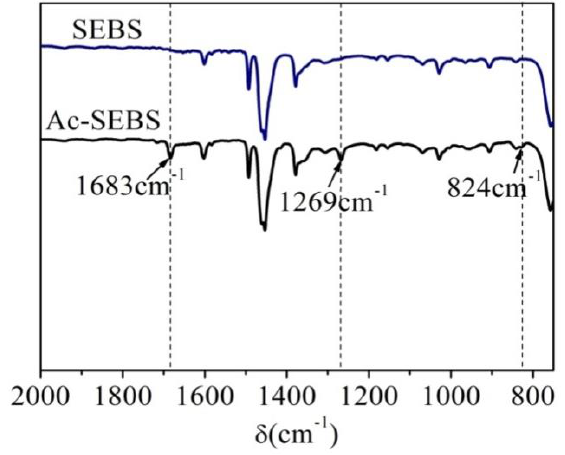
Figure 1. Fourier Transform Infrared Spectroscopy (FTIR) spectra of polystyrene-b-poly(ethylene- co - butylene)-b-polystyrene (SEBS) and Ac-SEBS.